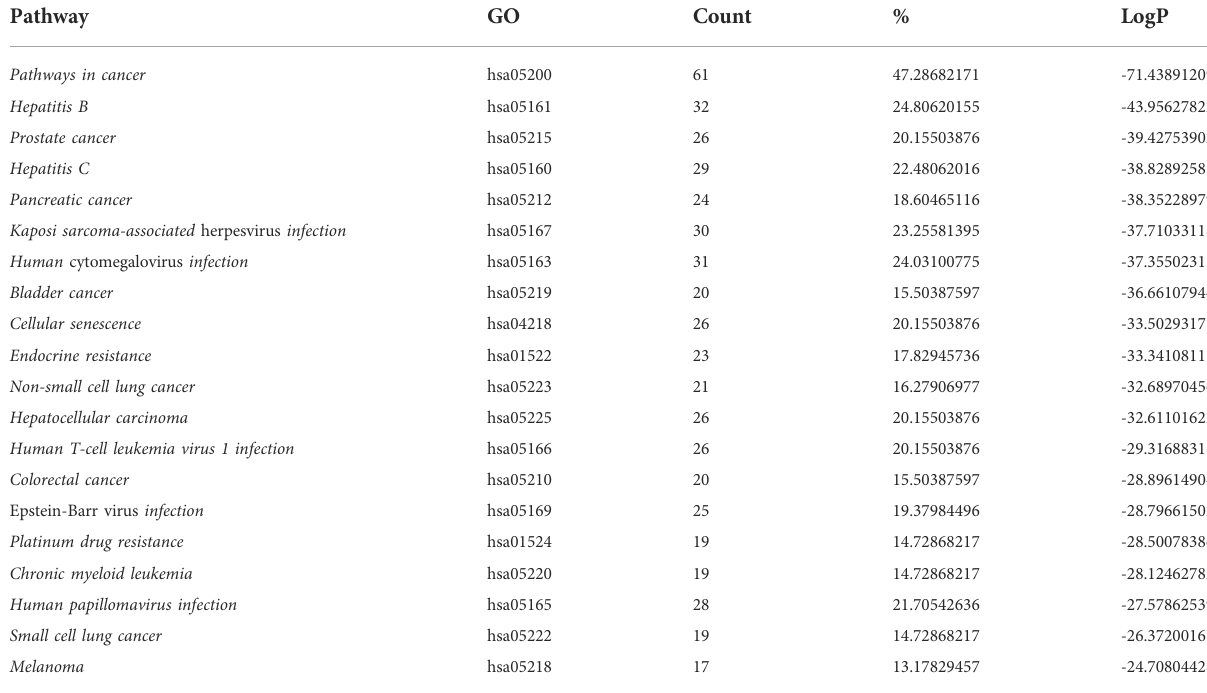
TABLE 6 Information of the key pathways of botanical drug